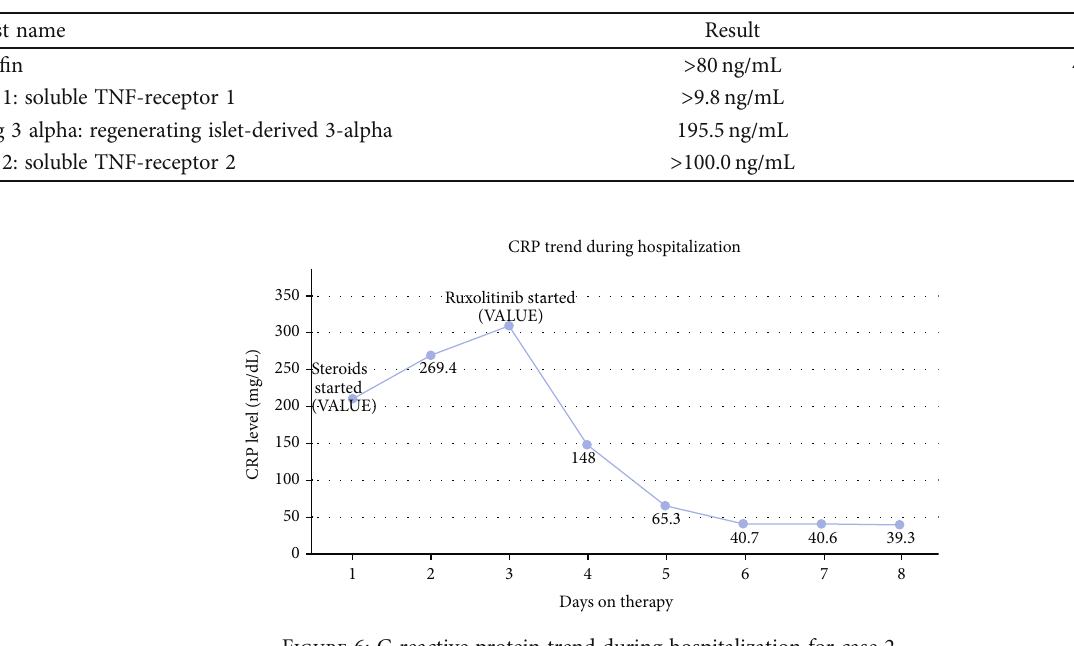
Figure 5: (a) Dyskeratotic cells in the epidermis (hematoxylin-eosin, original magni fi cation × 200). (b) Lymphocytes in close apposition to apoptotic keratinocytes (satellite cell necrosis), (hematoxylin-eosin, original magni fi cation × 400). Table 1: GVHD-speci fi c markers prior to initiation of ruxolitinib.